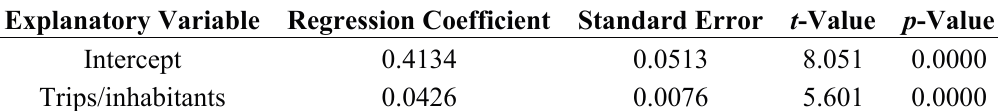
Table 2. OLS regression model: São Paulo, fatal VRU traffic